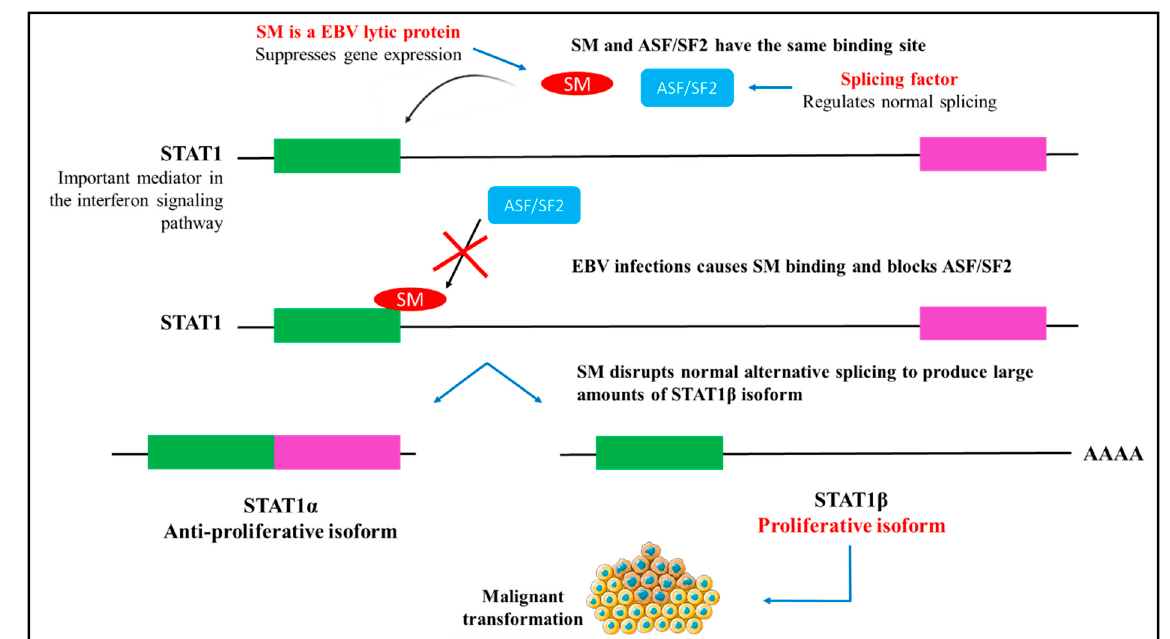
Figure 5. STAT1 and SM (a family of RNA binding proteins in the lytic phase) binding. SM and ASF/SF2 bind to the same region in STAT1. By binding to STAT1, SM regulates alternative splicing and disrupts the ratio of STAT1 α and STAT2 β isoforms by preferentially increasing the levels of STAT1 β . STAT1 α and β are principle mediators of the interferon signalling pathway to regulate proliferation, apoptosis and differentiation [67].